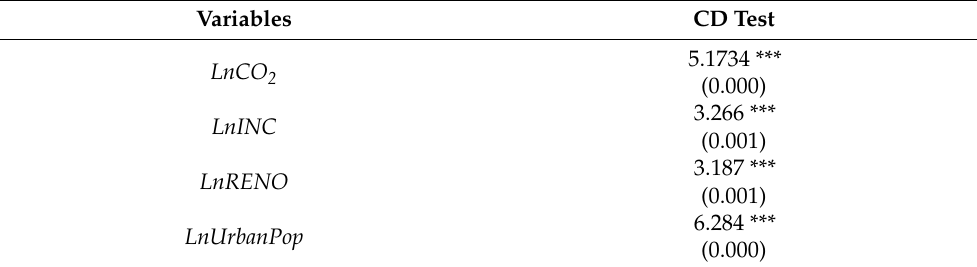
Table 3. Pesaran’s CD Test: Cross-Sectional Dependence.